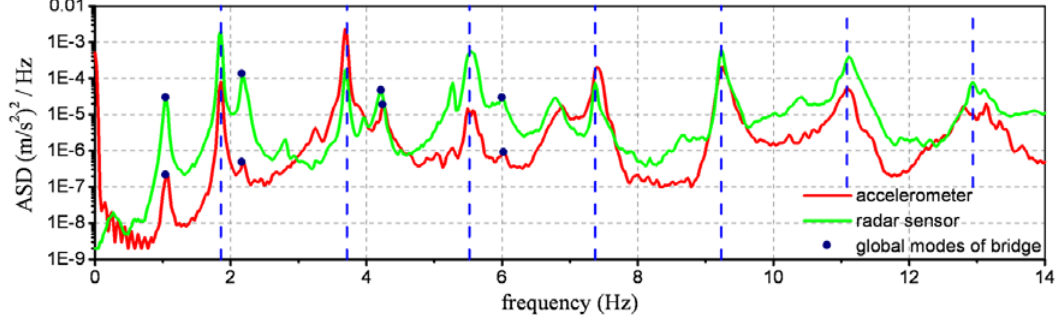
Figure 9. Comparison between the ASDs of cable S radar